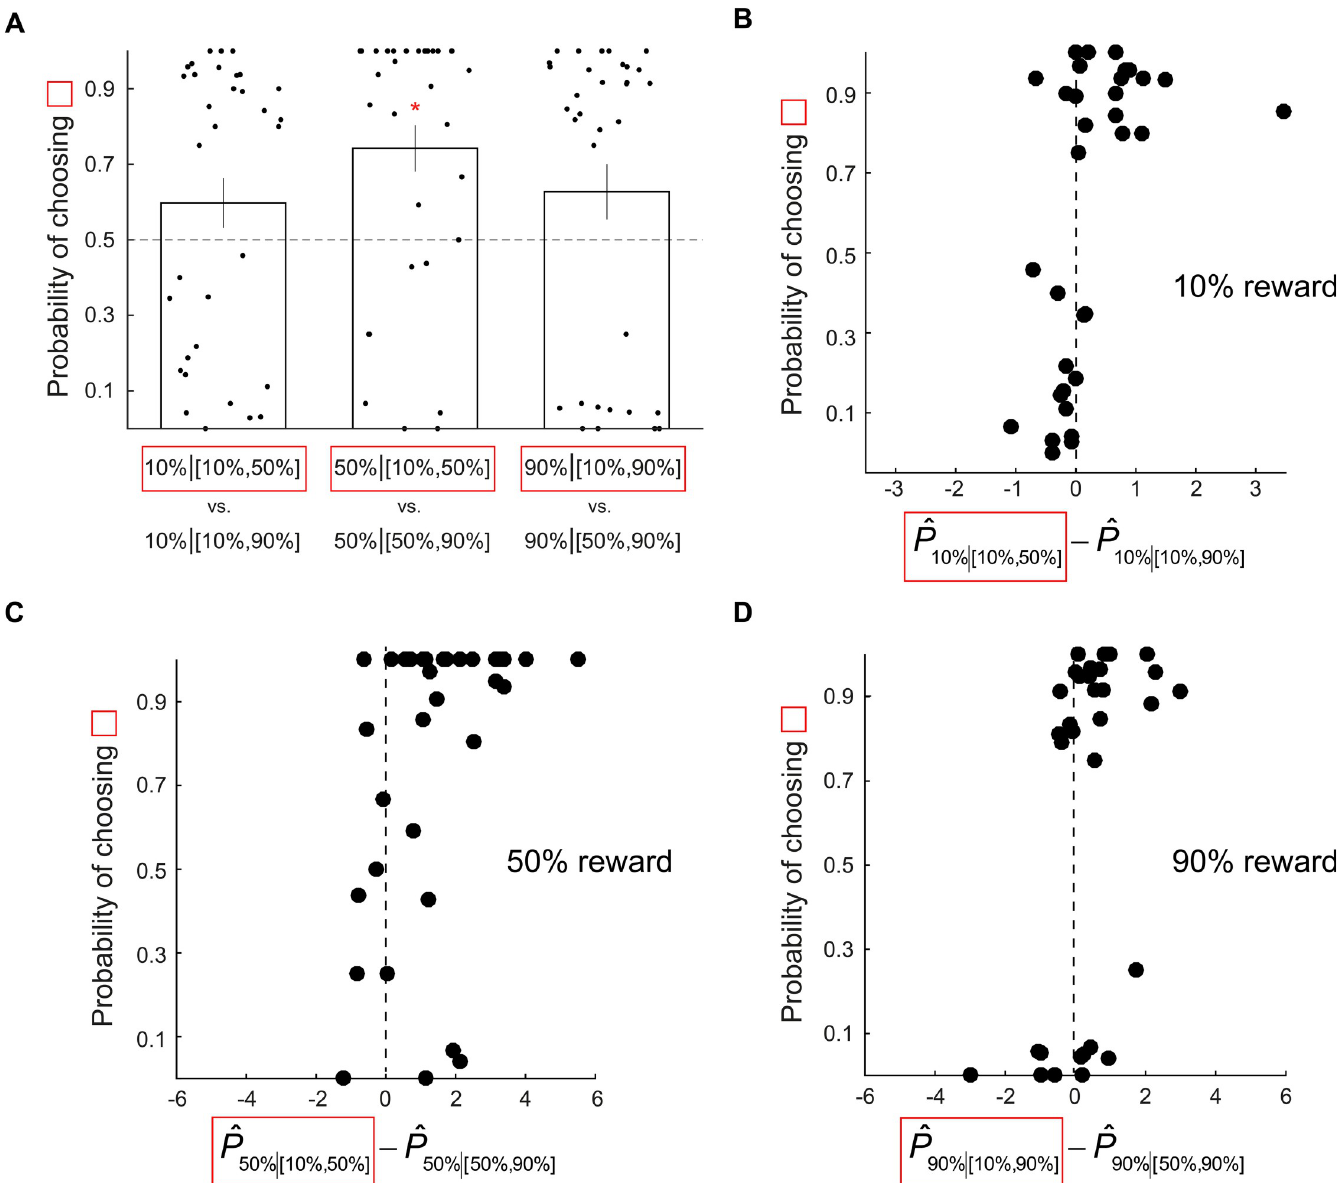
Fig 3. Experiment 1: Choice probability in the post-fMRI lottery decision task was predicted by context-dependent probability estimates in the fMRI session. (A) Three pairs of options, each representing a choice between two stimuli carrying the same reward probability but experienced in different contexts, are shown. For each pair, we plot the choice probability of the option highlighted in red. Each data point represents choice probability of a single subject. The bar indicates the mean choice probability averaged across all subjects. Error bars represent ± 1 SEM. For each pair, we tested whether the mean choice probability is different from 0.5. The red star symbol indicates significant difference in choice probability from 0.5 based on 95% bootstrap confidence interval. (B–D) Relation between choice probability and probability estimate. For each pair of options described above, choice probability is plotted against the difference in probability estimates subjects provided in the fMRI task. Each data point represents a single subject. (B) 10% reward pair. (C) 50% reward pair. (D) 90% reward pair. Data underlying these graphs can be found in https:// osf.io/48j7m.